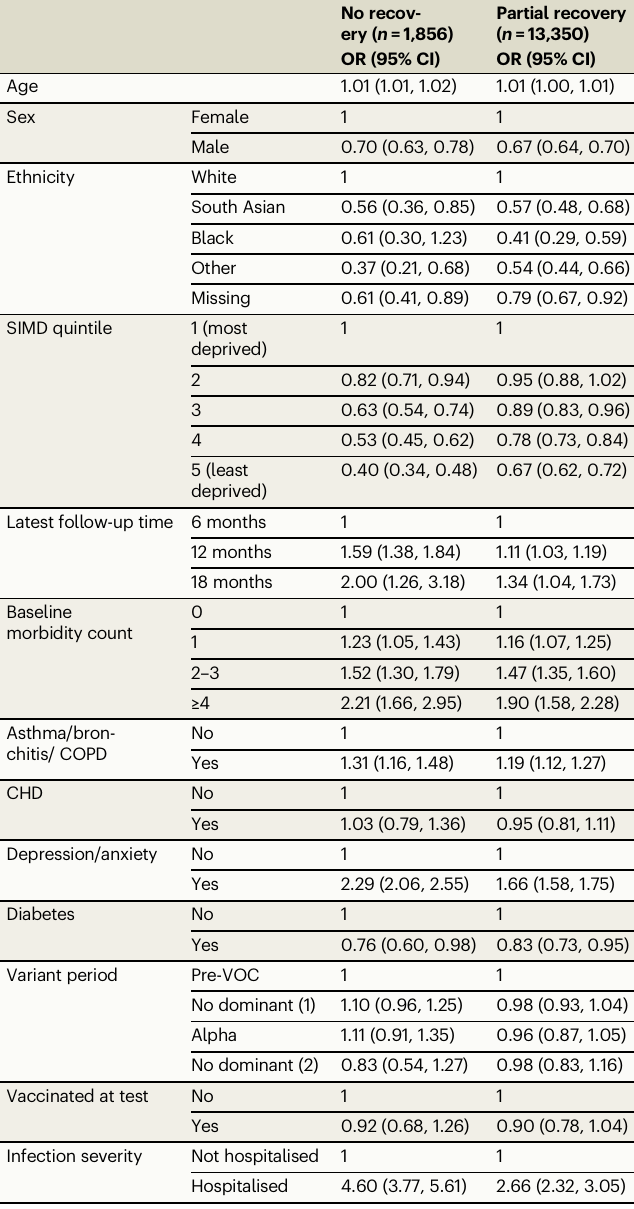
concern.All tests